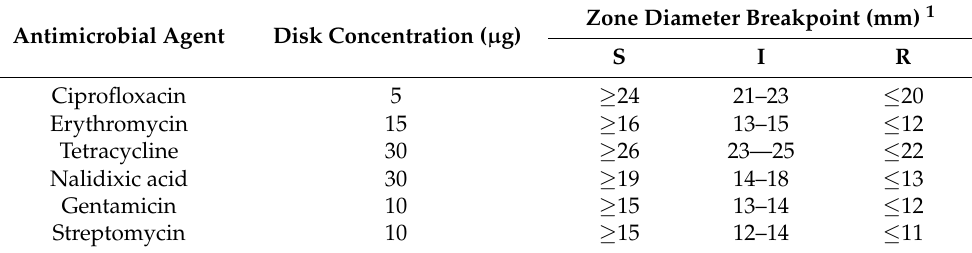
Table 1. Breakpoints of the disk diffusion method used to determine antimicrobial susceptibility of Campylobacter isolates. Antimicrobial